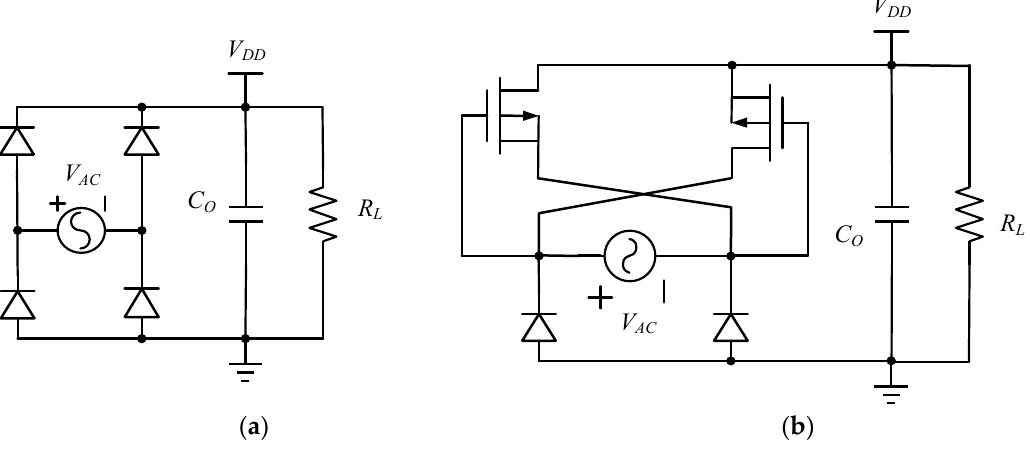
Figure 8. ( a ) FBR, ( b ) rectifier with cross-coupled PMOS. To further reduce the reverse current, an active rectifier based on PMOS with cross- coupling is proposed, to improve the efficiency. The power losses due to the voltage drop of the forward voltage can be greatly reduced by replacing the diode with actively controlled transistors. Chang et al. have proposed a rectifier with active and non-overlapping control, as shown in Figure 9: the unbalanced comparator reduces the reverse current, and the non-overlapping control minimizes the additional losses caused by the transistors turning on and oscillating at the same time, and improves the power extraction efficiency and the voltage conversion ratio [51]. In this way, a PCE of 95% can be achieved at 20 kΩ and 200 kΩ load conditions.